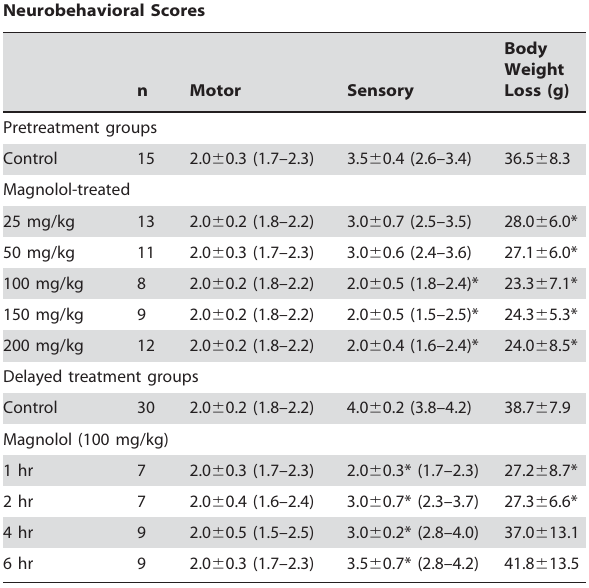
Table 3. Neurobehavioral scores and body weight loss obtained after permanent middle cerebral artery occlusion (pMCAO) in each pretreatment group in the